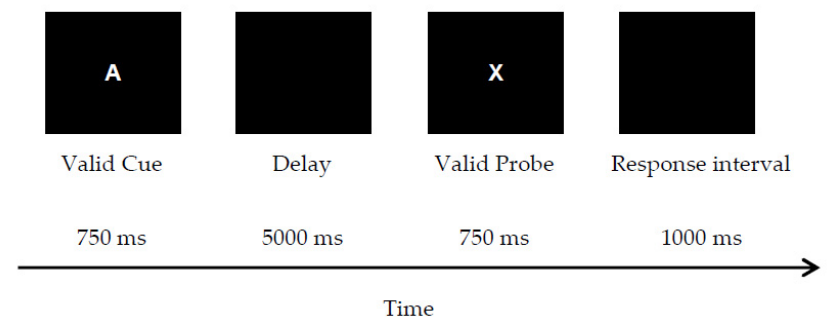
Figure 1. Sample trial procedure for a target trial in the letter-cue AX-CPT (Experiment 1). Participants began with a practice block of five trials, followed by two experimental blocks, each including 100 trials: 70 target and 30 non-target trials (10 for each of the non- target trials: cue-lure, probe-lure, and control). The trials were presented in a pseudo-randomized order. Each block lasted for approximately 14 min. Feedback (i.e., correct or in- correct) was provided only for the practice trials.